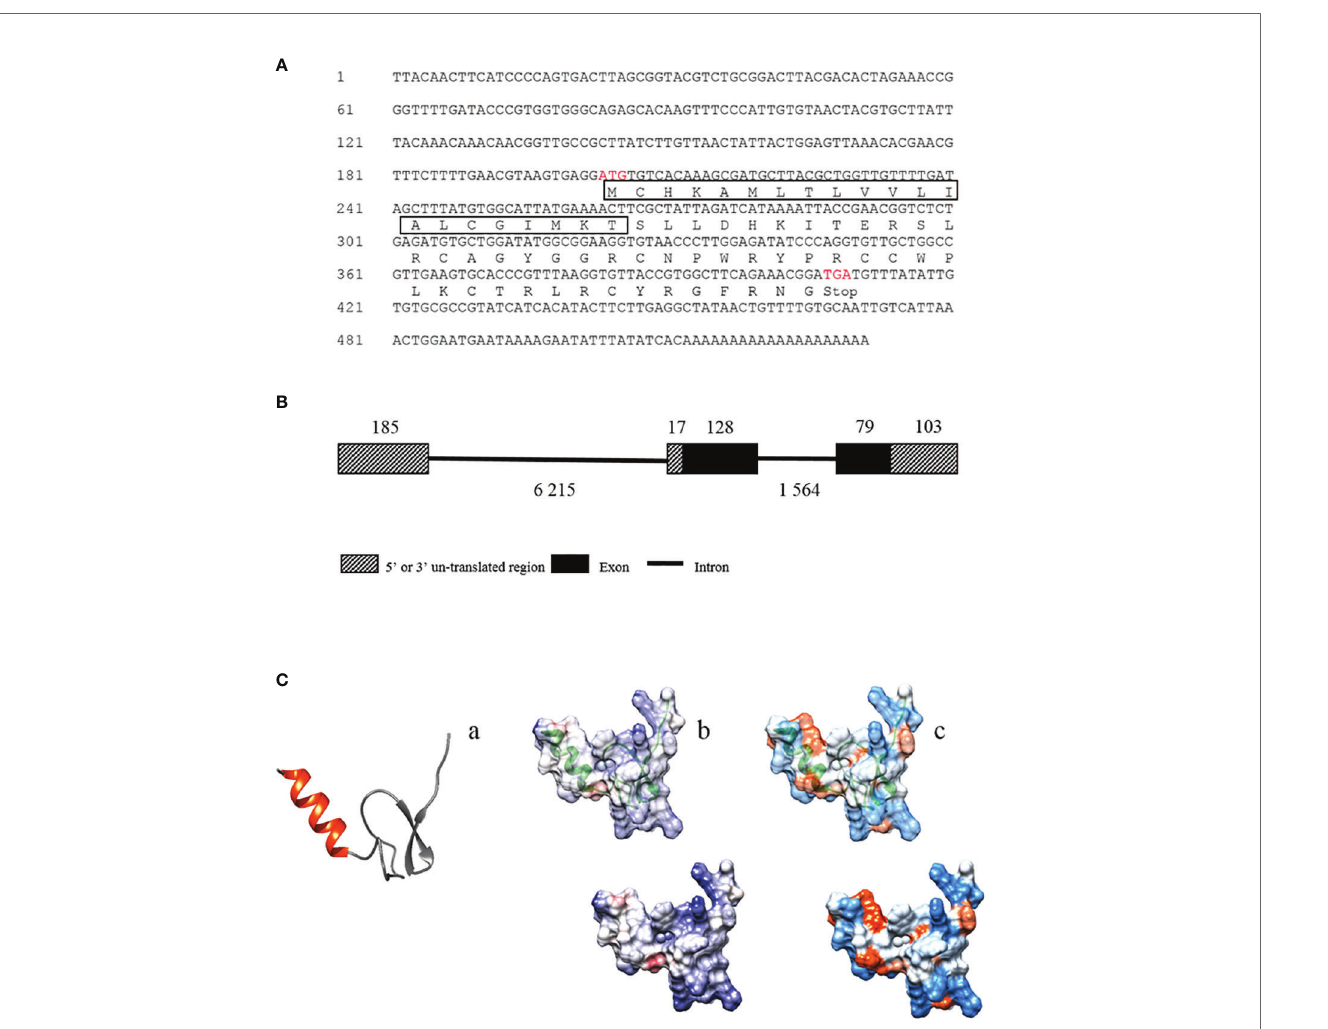
FIGURE 1 | The mRNA and deduced amino acid sequences of Tatritin and the structural analysis. (A) The mRNA and deduced amino acid sequences of Tatritin . The box shows the predicted signal peptide, and the red letters show the predicted start and stop codons. Schematic diagram of the gene (B) and peptide structure (C) of Tatritin. Tatritin with a -helix in red and cys-stabilized b -sheet in gray ( C -a); analysis of electrostatic surface, positive charges in blue and negative charges in red ( C -b); hydrophobicity surface analysis, hydrophobic regions with warmer colors ( C